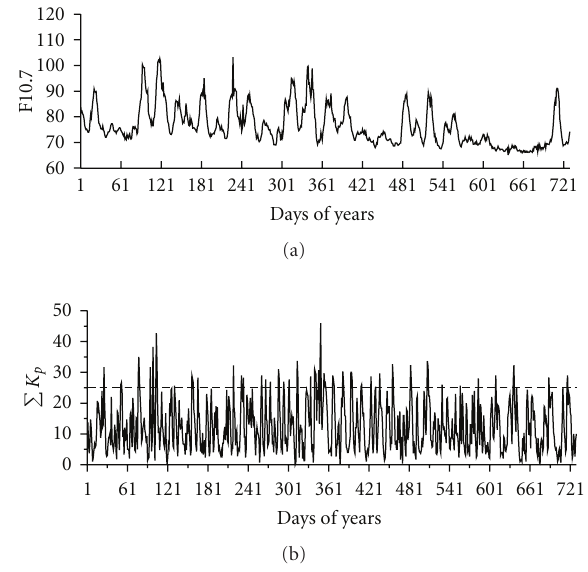
Figure 1: Variations of the F10.7 (a) and daily summary index of magnetic activity Kp (b) during 2006-2007. The quiet level is shown by a dotted